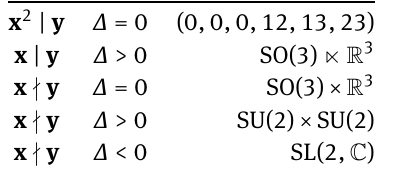
Table 1.1: The five models of invariant intrinsic torsion geometry.